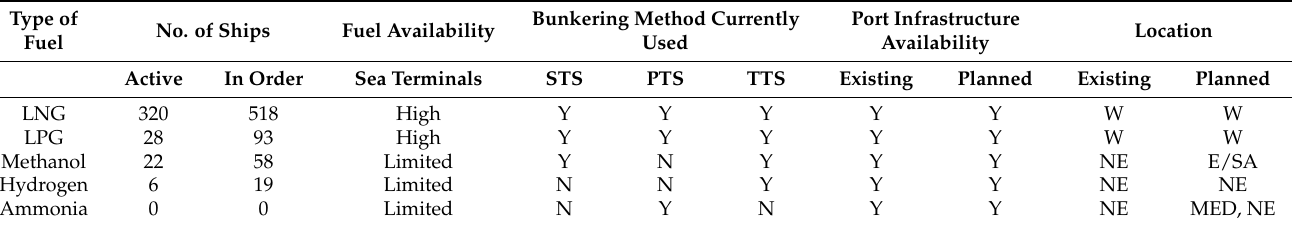
Table 7. Summary of numbers of vessels, fuel availability, bunkering methods currently in use, and planned infrastructure regarding bunkering alternative fuels.